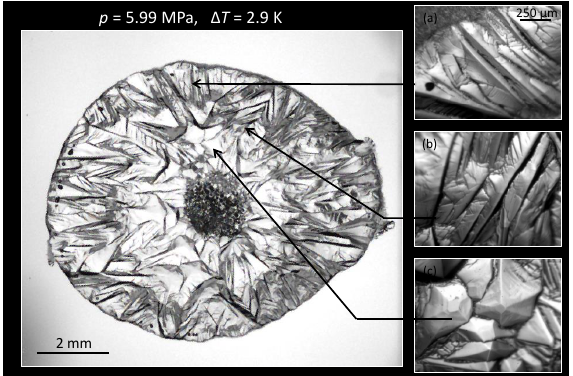
Figure 5. Replicates of methane hydrate formation from an aqueous MEG solution droplet subject to a temperature gradient. w MEG = 10%, p = 5.99 MPa, T C = 275.0 K, T H = 279.0 K, and T HLV = 279.7 K. Each panel shows a different experiment.